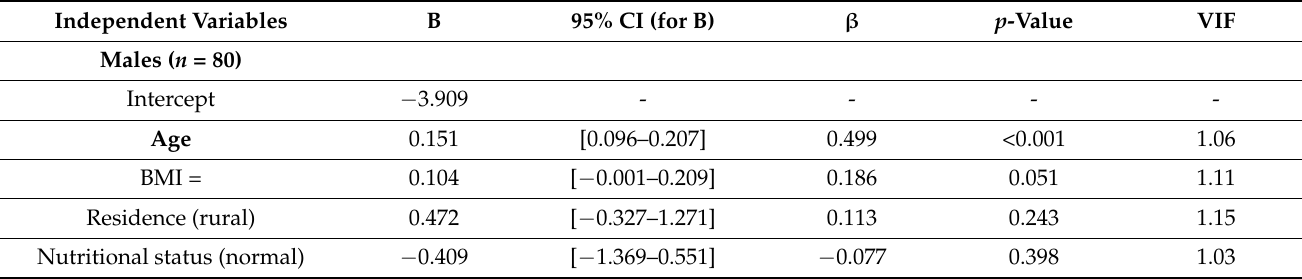
Table 3. Regression coefficients (B) and standardised regression coefficients ( β ) with 95% confidence intervals (95% CIs) for independent variables with TUG time in males (R 2 = 37.4%) and females (R 2 = 49.9%). Independent Variables B 95% CI (for B) β p -Value VIF Males ( n = 80) Intercept − 3.909 - Age 0.151 [0.096–0.207] BMI = 0.104 Residence (rural) 0.472 Age Nutritional status (normal) −